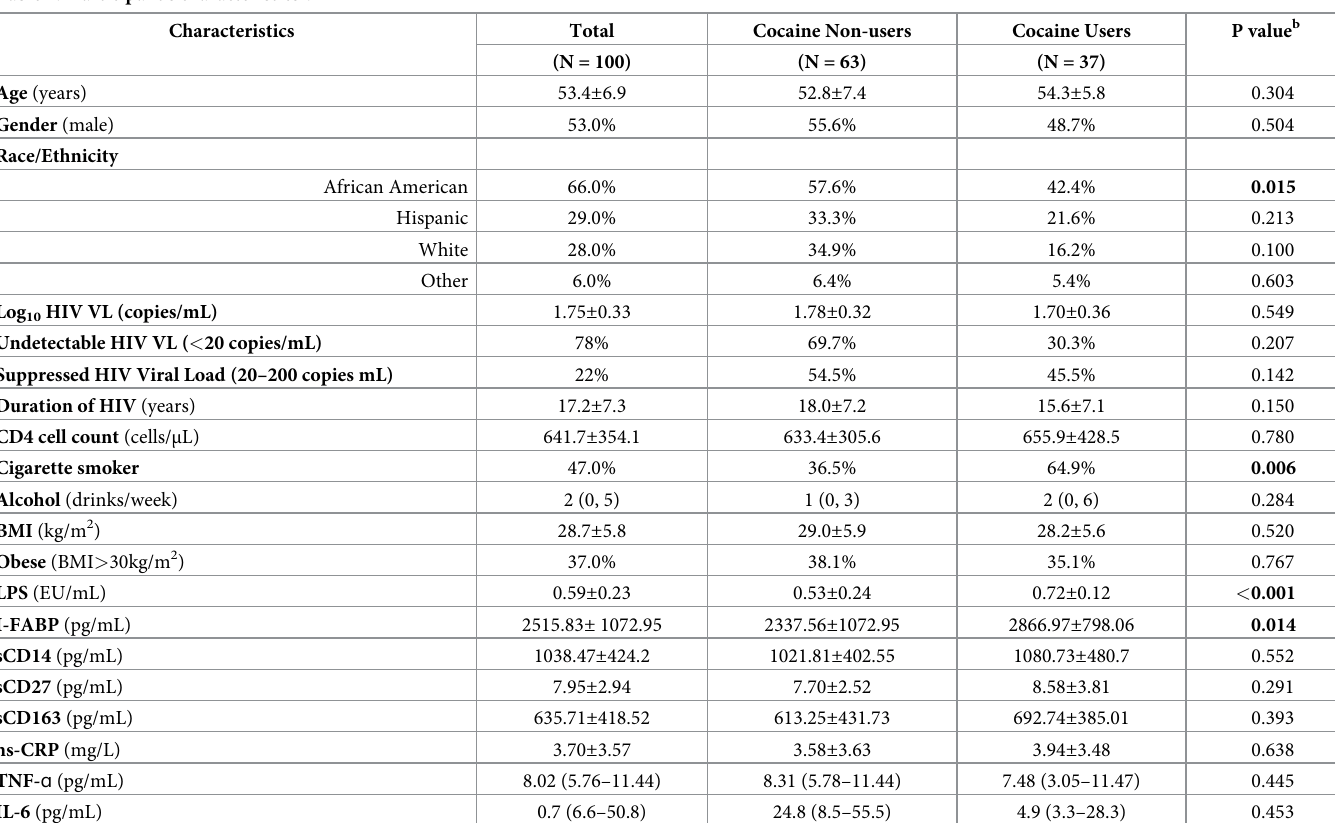
Table 1. Participant’s characteristics a . Characteristics